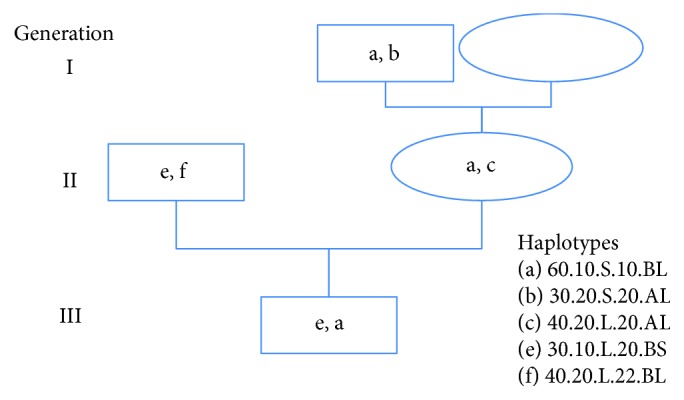
Segregation of 20 Mb haplotype through three generations of Wagyu pedigree. Haplotype (a) is an inherited intact from the maternal grandsire. The calf, dam, and maternal grandsire are all heterozygous at the SREBF1 or NT5M and GH or FASN markers, which allows the segregation of haplotype (a) to be seen clearly.